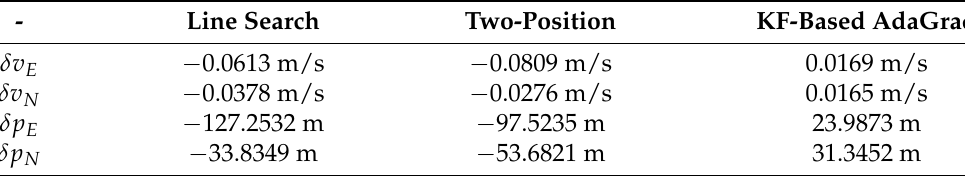
Table 8. Maximum errors of velocity and